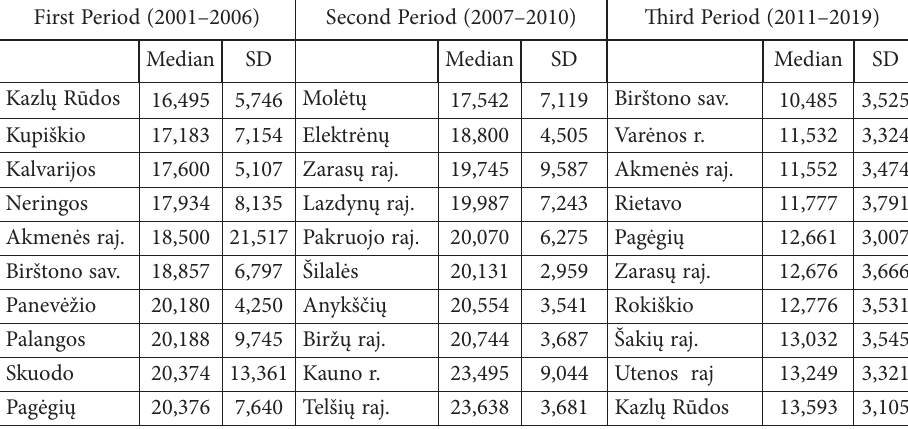
Table 3. Municipalities with the 10 smallest shadow economies